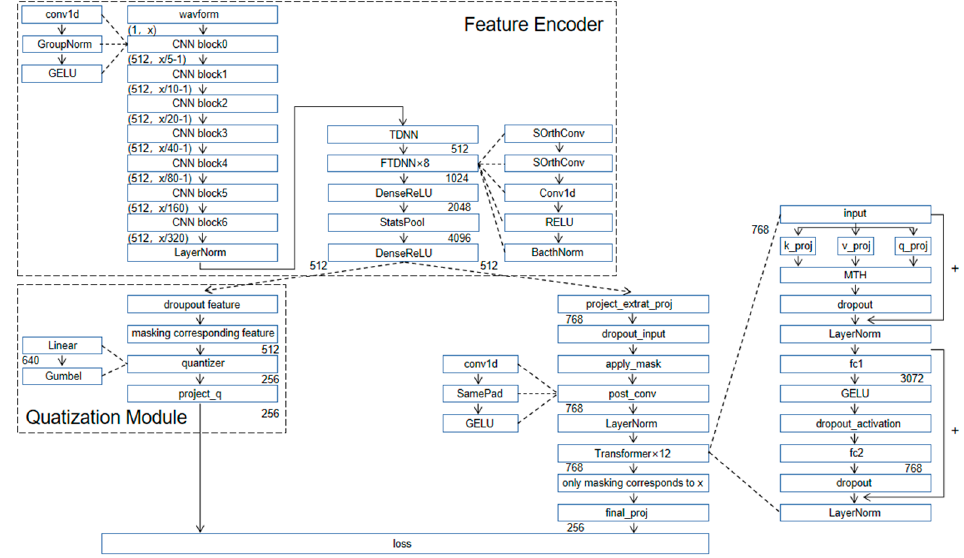
Figure 5. Illustration of the overall network structure of our proposed model.